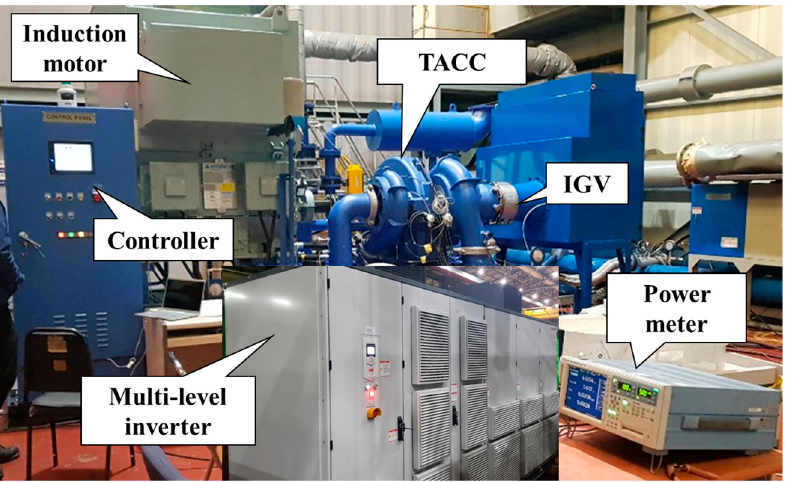
Figure 7. Experimental setup for performance evaluation of TACCS. TACC: turbo air centrifugal compressor.